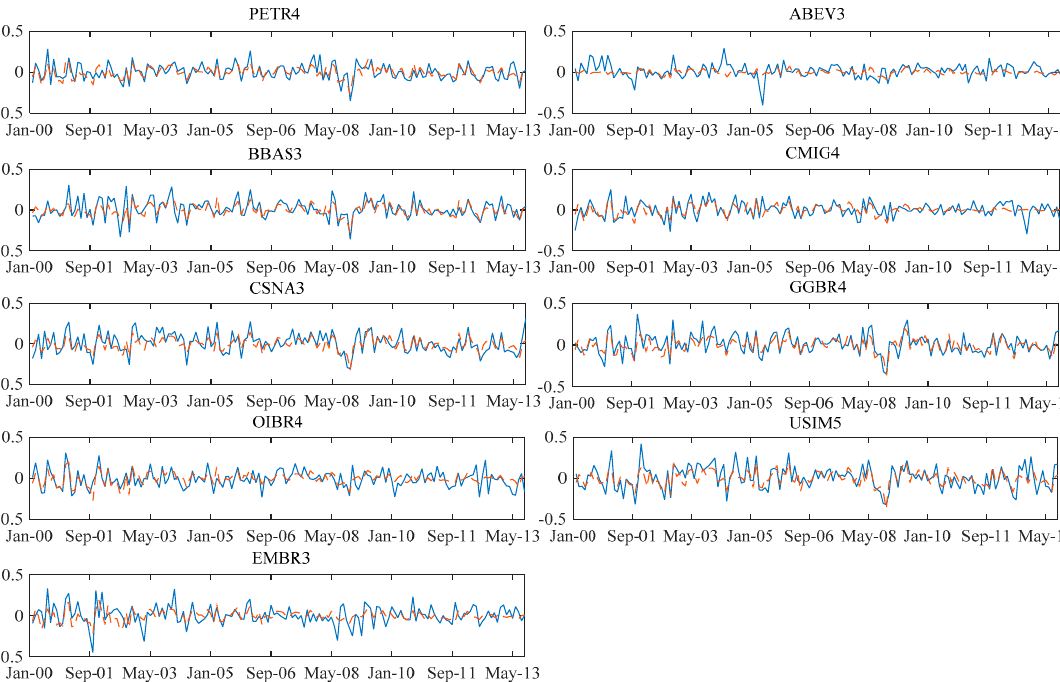
Figure A4. Actual (blue line) versus predicted (red line): Random walk models.